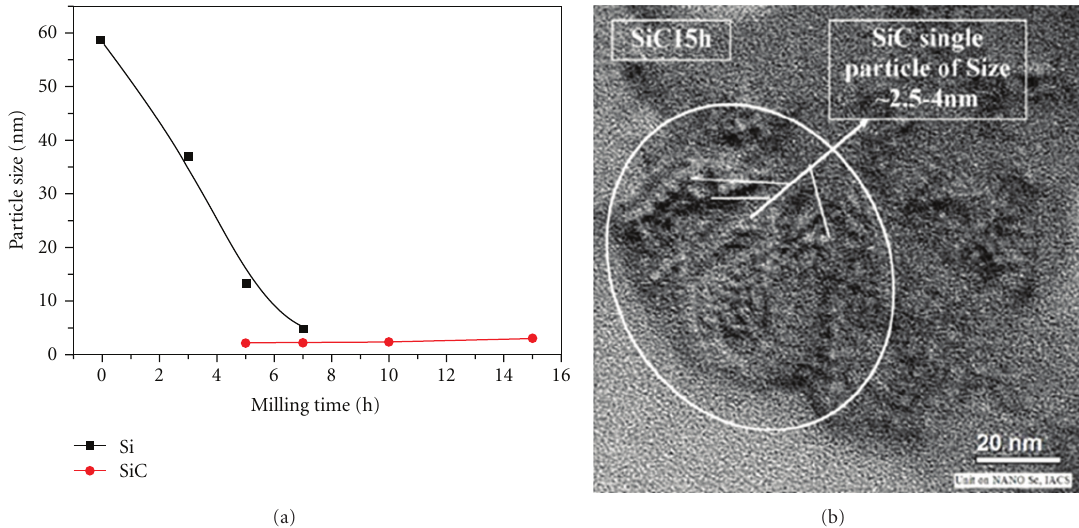
Figure 1: (a) Particle size of Si and SiC phases in unmilled and ball-milled mixture of Si and graphite (1:1 mol) with increasing milling time. (b) HRTEM micrograph of SiC phase after 15h